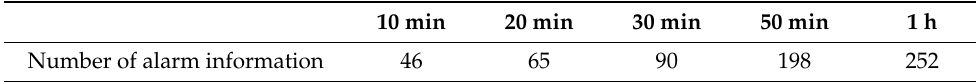
Table 3. Sample composition of actual alarm information